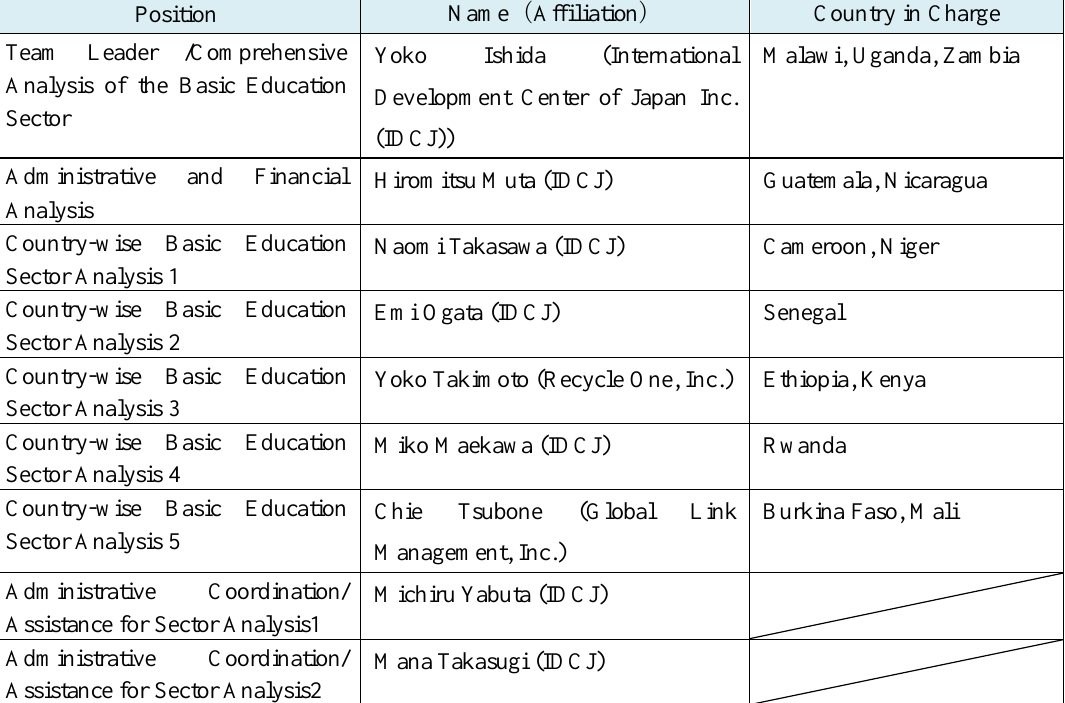
Table 1-1 ： Team Members of the Study and the Countries in Charge Position Name （ Affiliation ） Country in